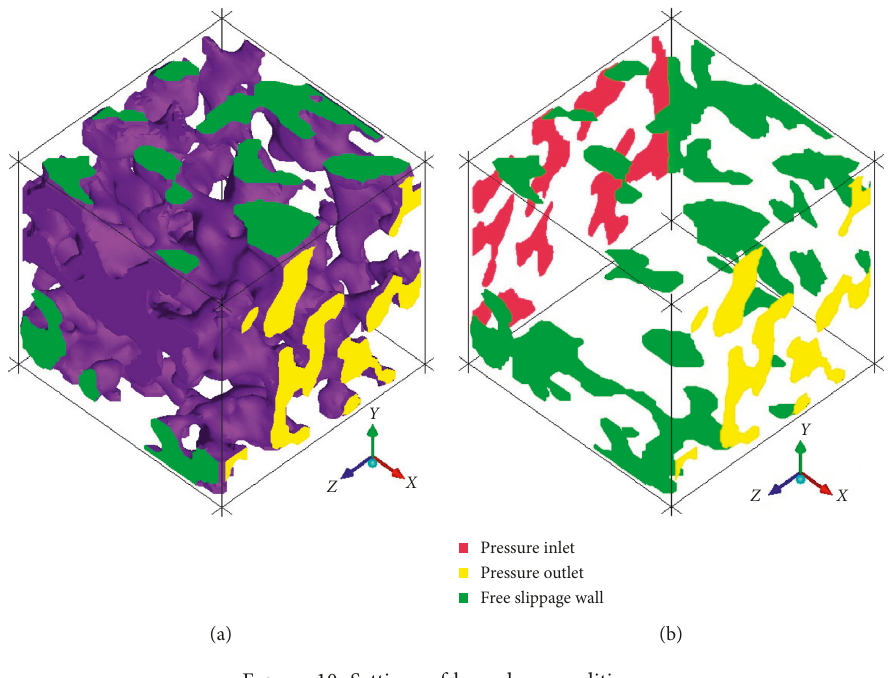
Figure 10: Settings of boundary